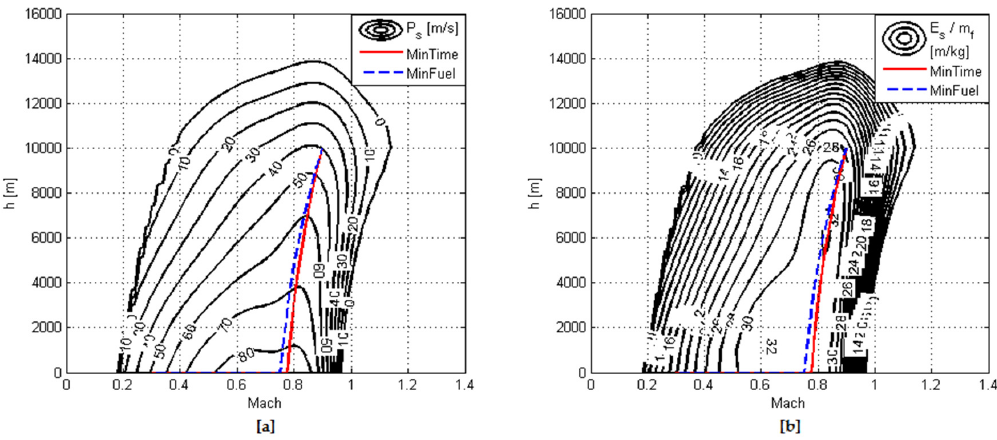
Figure 15. Case A, Configuration C3; Minimum Time and Minimum Fuel climb paths, plotted over contours of: Specific Excess Power (m/s) ( a ); and Energy Efficiency (m/kg) ( b ).